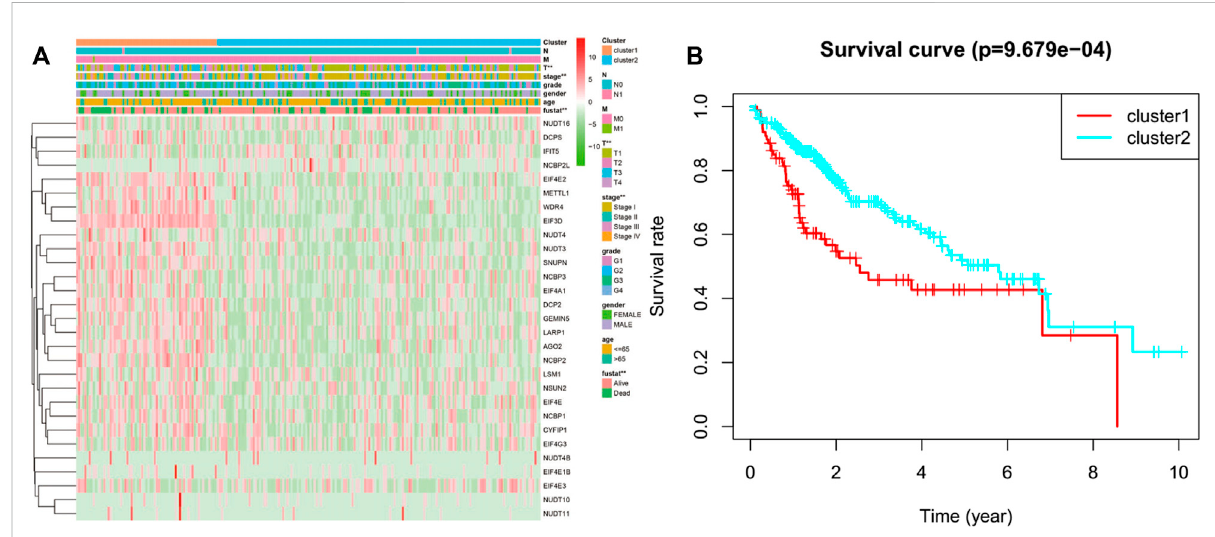
FIGURE 3 Differences between cluster one and cluster two in clinicopathological features and overall survival. (A) Heatmap and clinicopathological features of the two clusters. Green stands for low expressions, and red stands for high expressions. (B) Compare the overall survival (OS) distribution of cluster one and cluster 2. * p < 0.05, *** p <